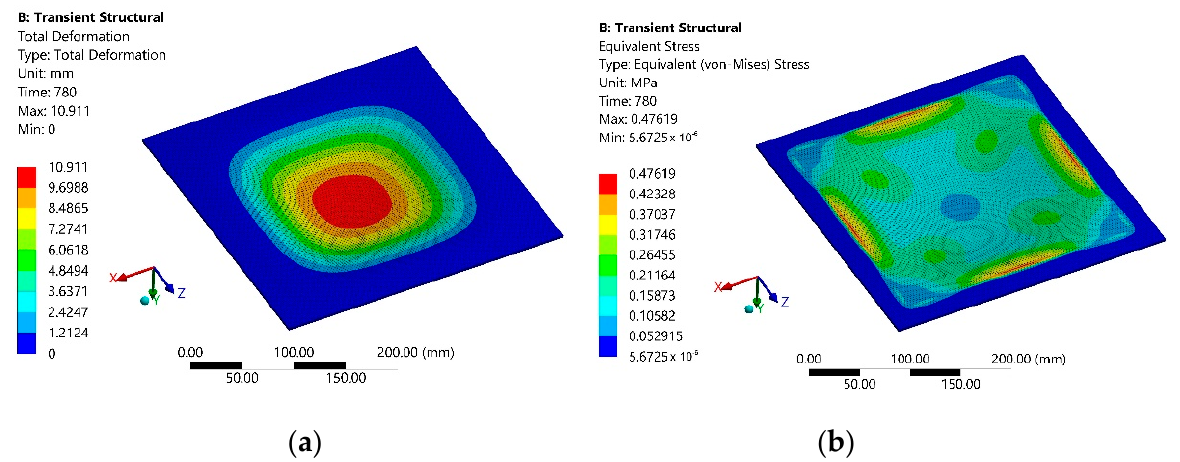
Figure 5. Modeling results of the second stage after 780 s from the heating beginning: ( a ) total deformation; ( b ) equivalent